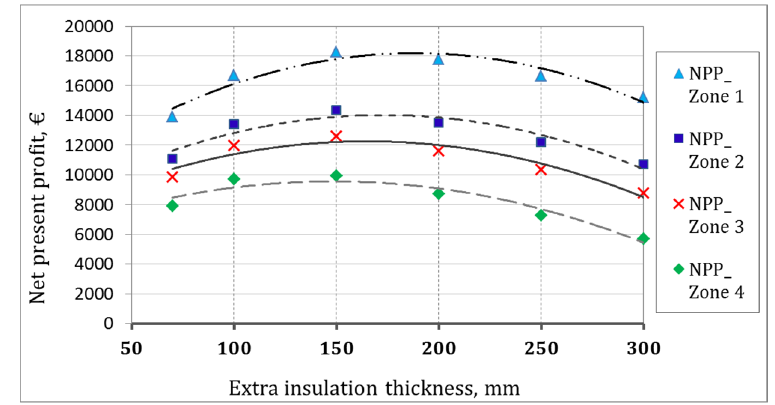
Figure 12. Net present profit of additional insulation on the basement wall for the base case scenario.